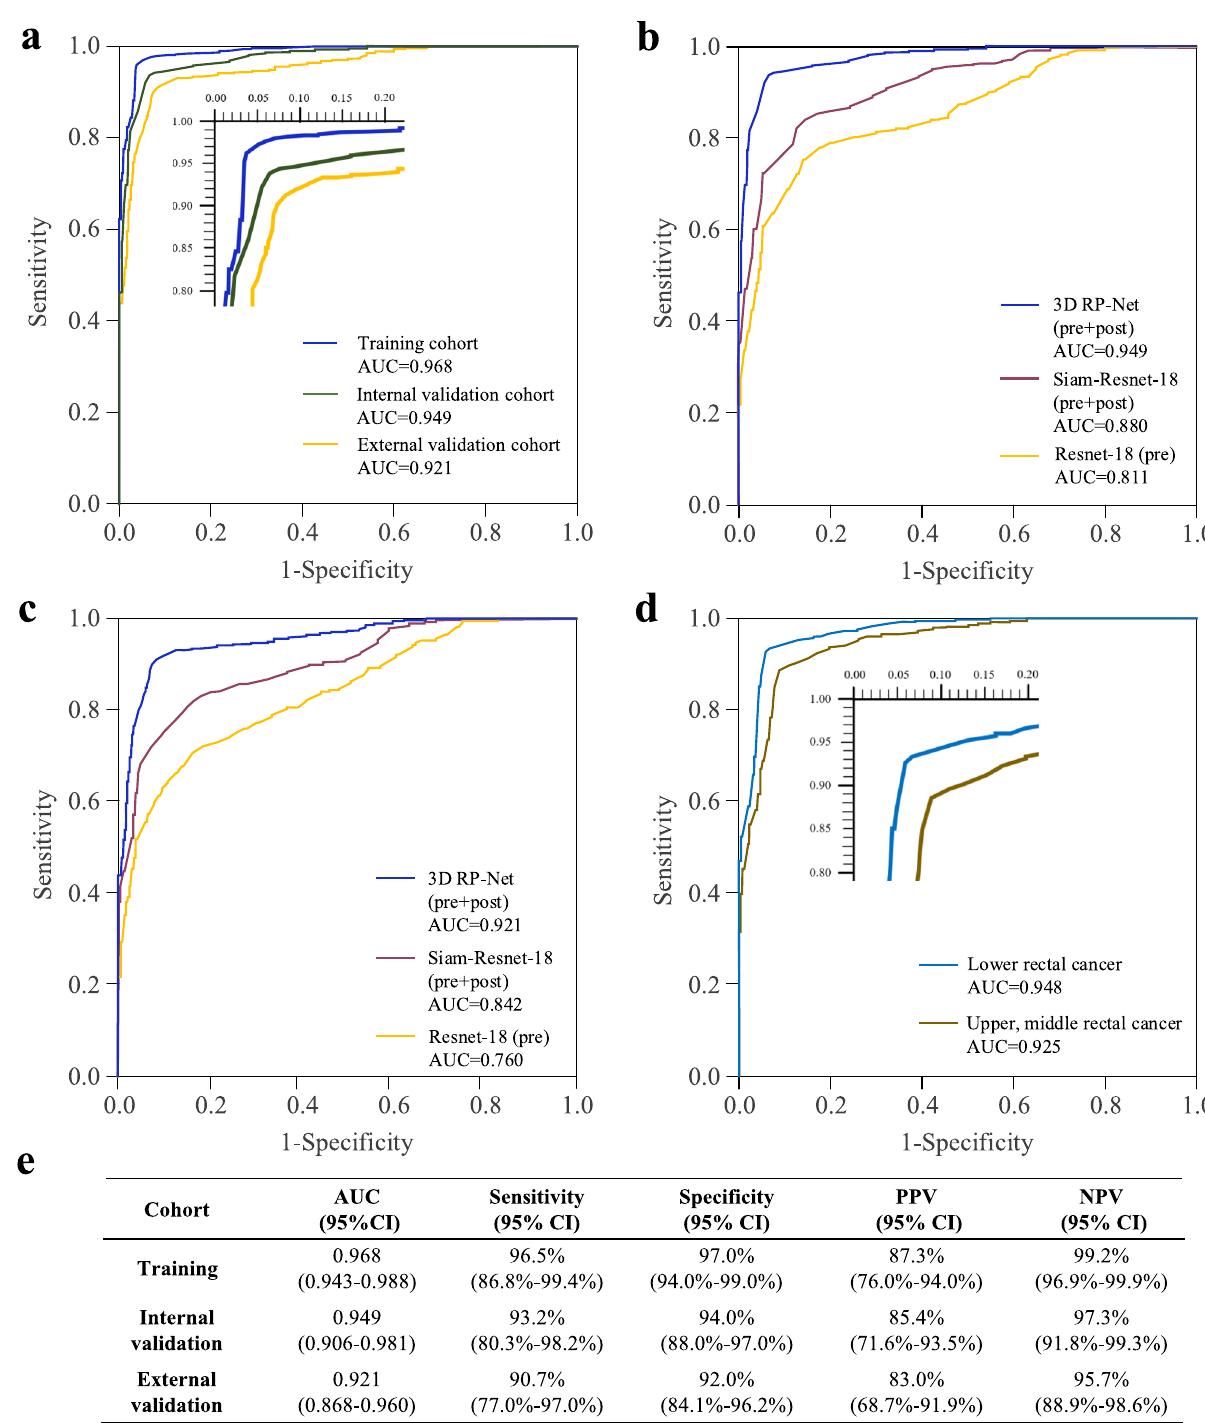
Fig. 3 Performance for predicting pathologic complete response. a Receiver operating characteristic (ROC) curves of the proposed 3D RP-Net in the training and two validation cohorts. b ROC curves of three different network models in the internal validation cohort. c same as ( b ), except for external validation cohort. d ROC curves in the subgroup of patients with upper, middle, and lower rectal cancer in the internal validation cohort. e Detailed information for prediction performance of the proposed model in the study cohorts. AUC, area under the ROC curve; PPV, positive predictive value; NPV, negative predictive